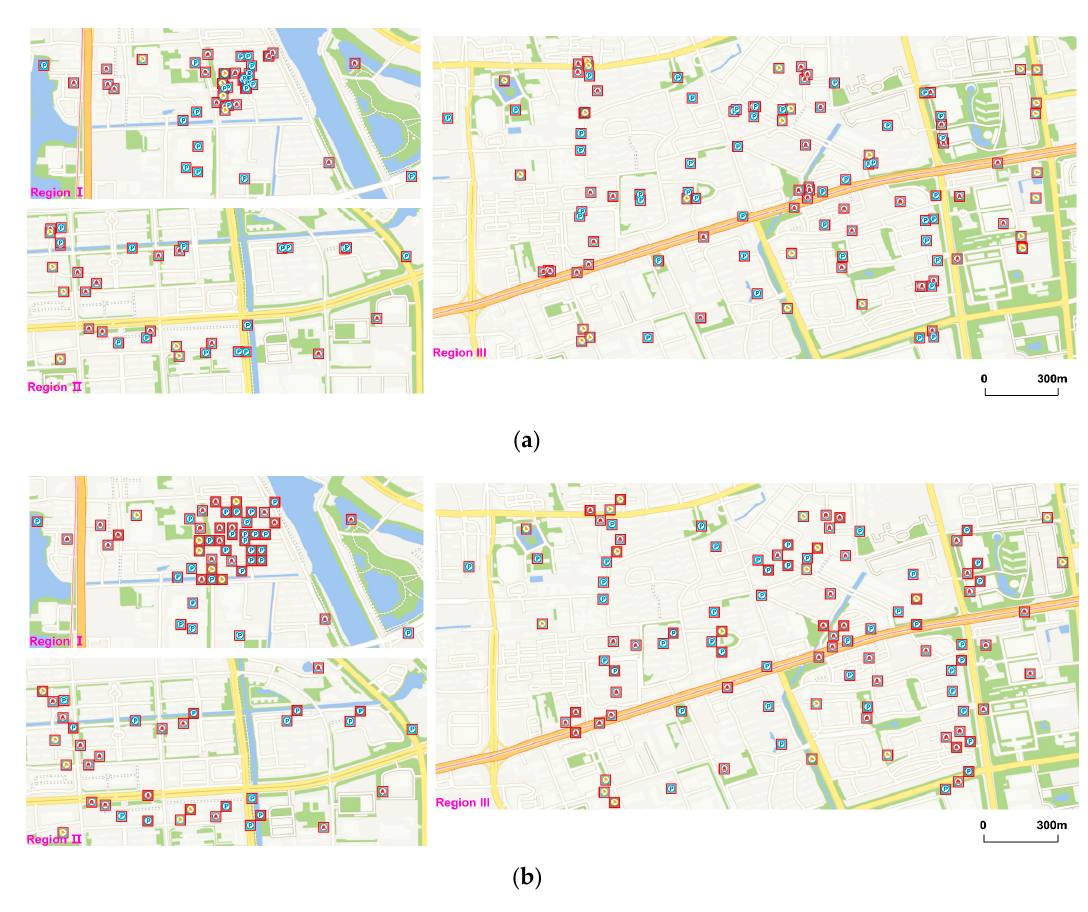
Figure 11. Original points and generalization results at LOD 16. ( a ) original points in three regions (shown in Figure 9a) at LOD 16; ( b ) generalization results in these regions at LOD 16.